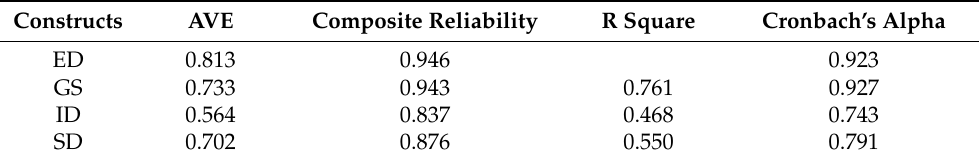
Table 7. Hypotheses test.